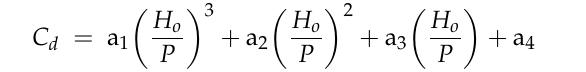
Table 3. Empirical constants of the discharge coefficient equation.